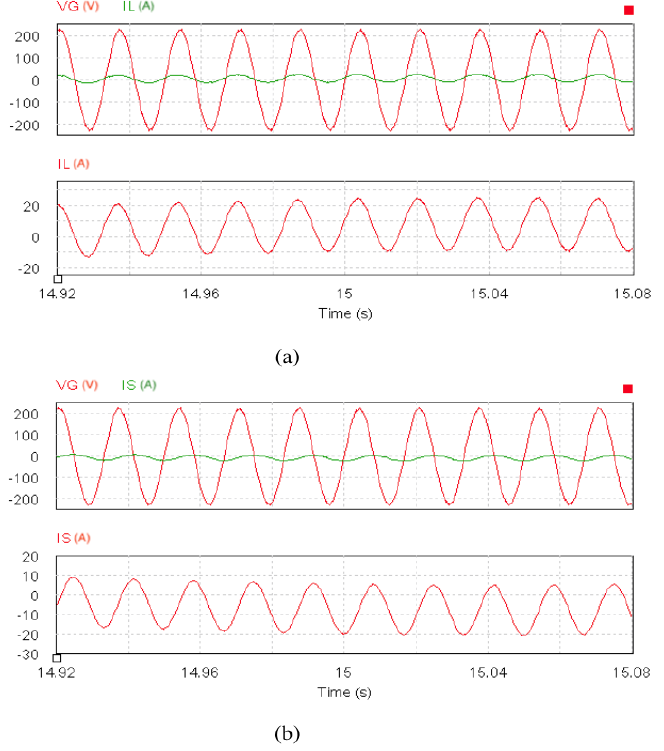
Figure 9. Simulation results in active power compensation mode: ( a ) The voltage and current waveforms at the output of inverter, ( b ) The voltage and current waveforms of AC